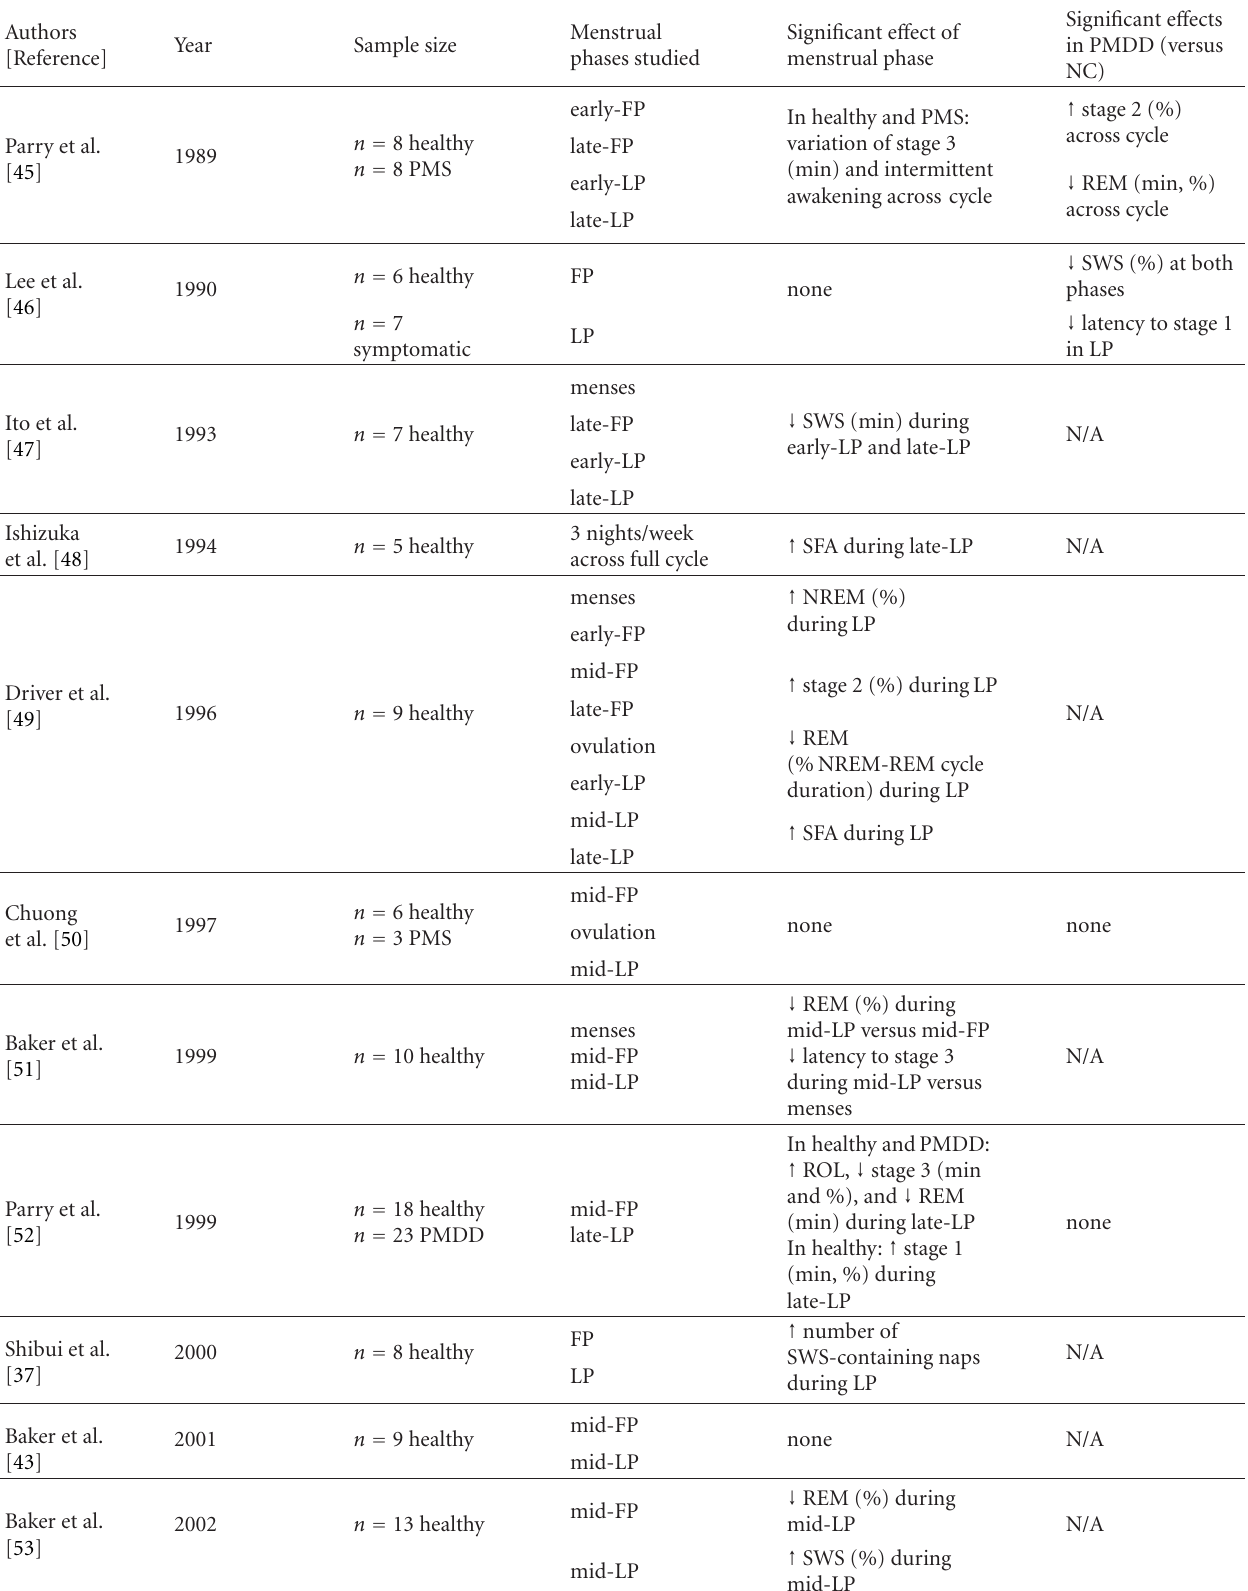
Table 1: The variation of sleep across the menstrual